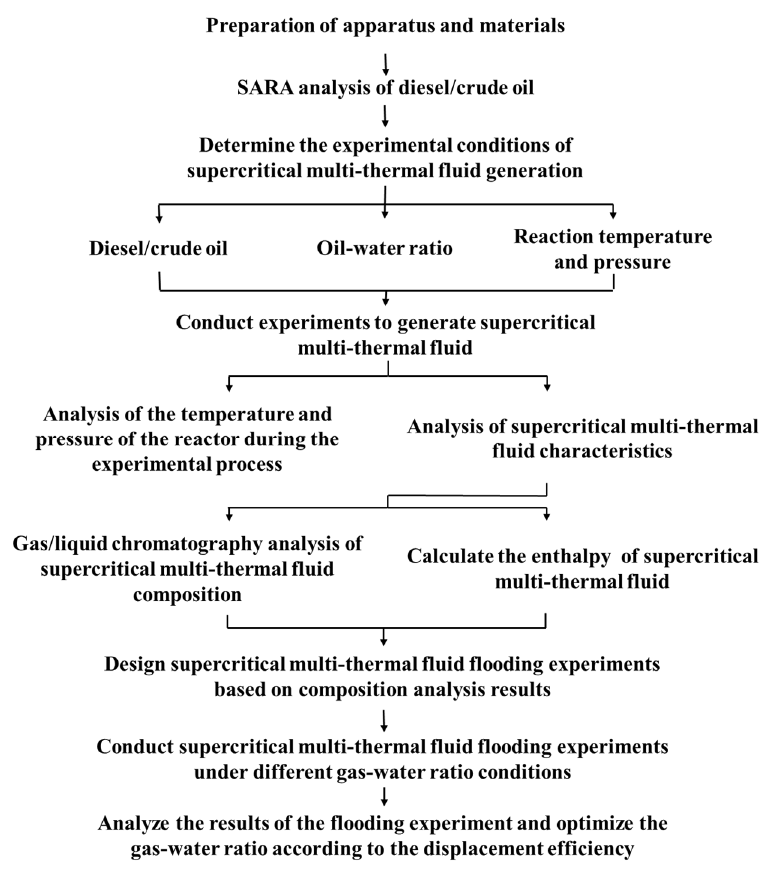
Figure 2. Workflow of experiments in this study.